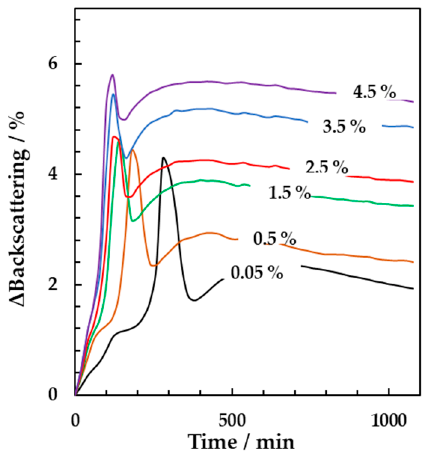
Figure 3 . Backscattering signals acquired over 1080 min in the middle of the vial (height equal to 20 mm) at incubation temperature of 44 °C. The signals were obtained at different concentrations of yogurt starter culture from 0.05% to 4.5% ( w/w ). Results are mean values of triplicates.